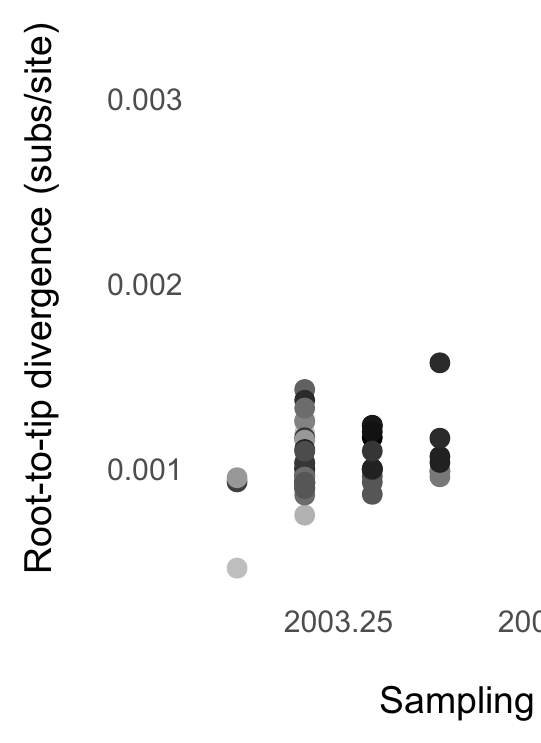
FIGURE 4 No evidence for punctuated evolution in SARS-CoV-1. The best- fi tting model is the model without predictors (node count and sampling time).